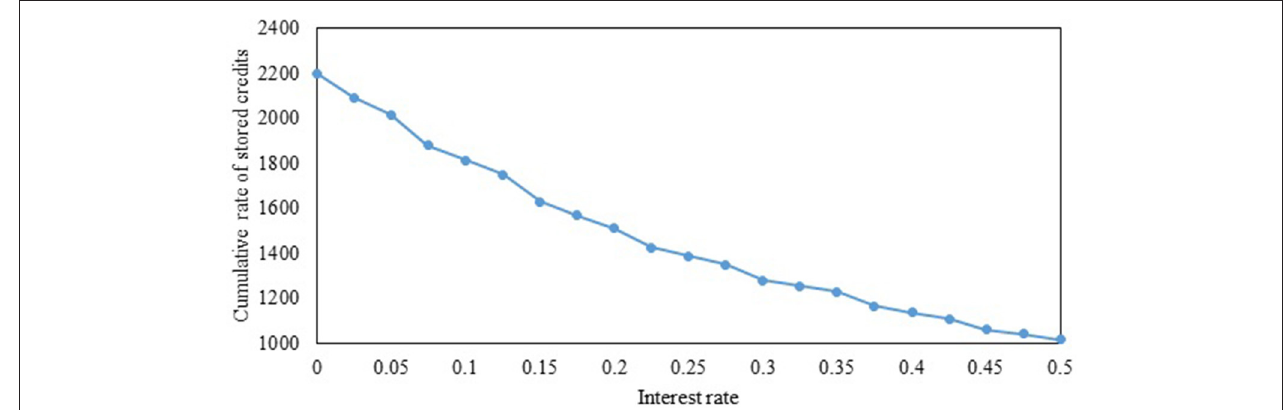
FIGURE 5 | Impact of interest rate on the cumulative rate of stored credits over the planning horizon.